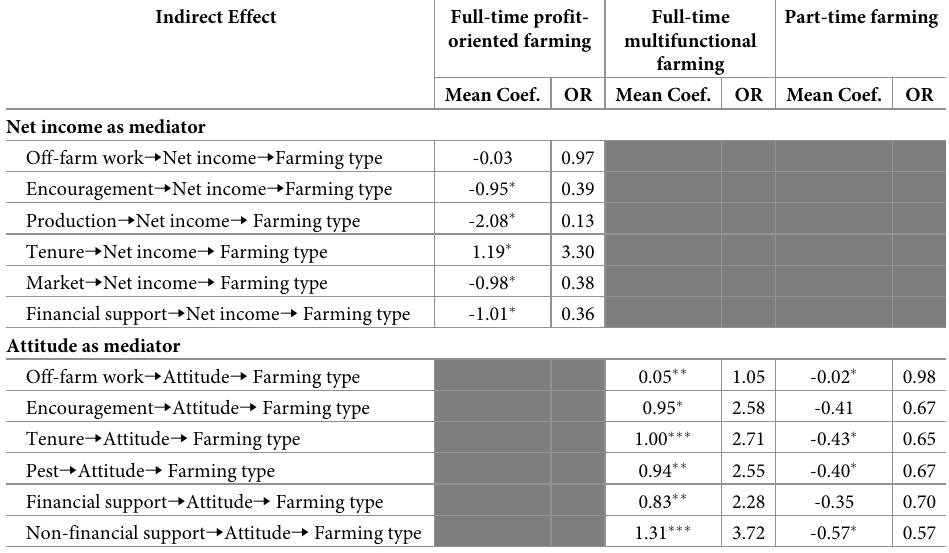
Table 2. Result of Monte Carlo approach for computing and testing significance of indirect